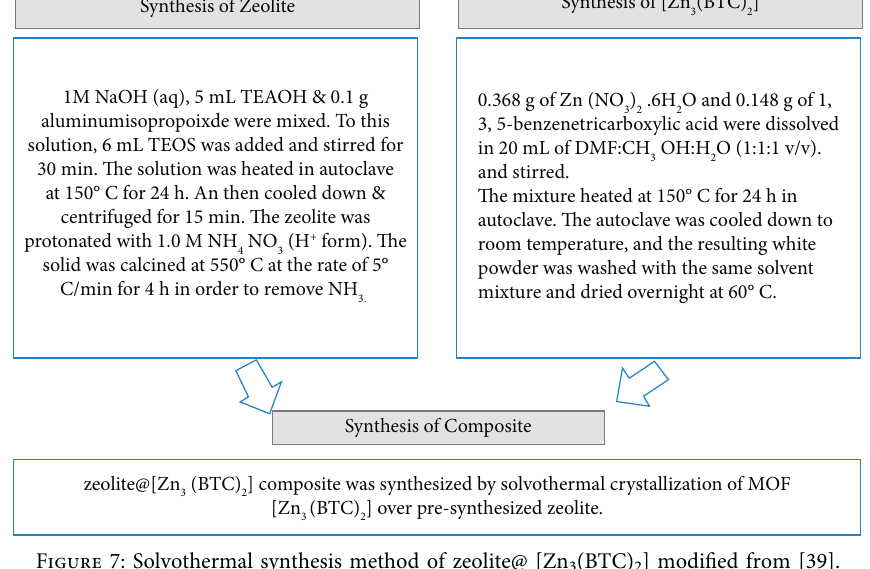
3 (BTC) 2 ] modifed from